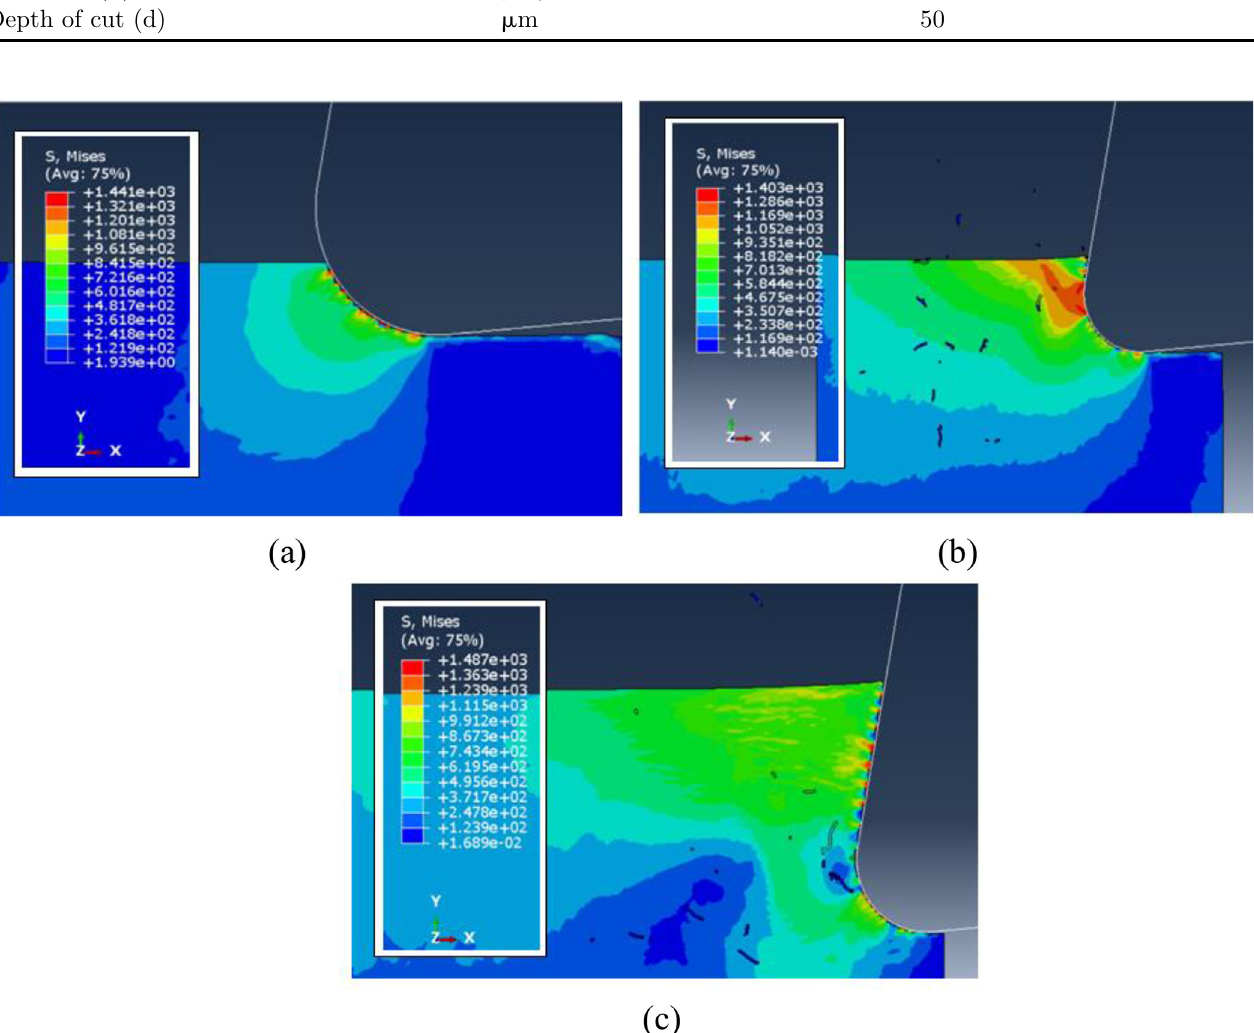
Fig. 4. Predicted Von-Mises stress distribution at spindle speed of 60,000rpm, depth of cut 50 m m and (a) 0.5 m m/tooth, (b) 3 m m/ tooth and (c) 6 m